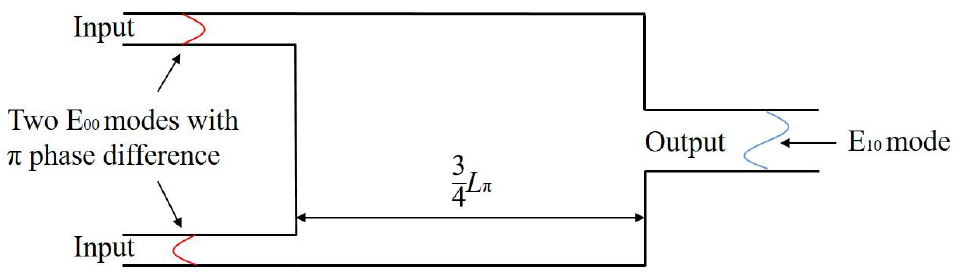
Figure 1. Diagram of MMI as E 00 -E 10 mode converter.